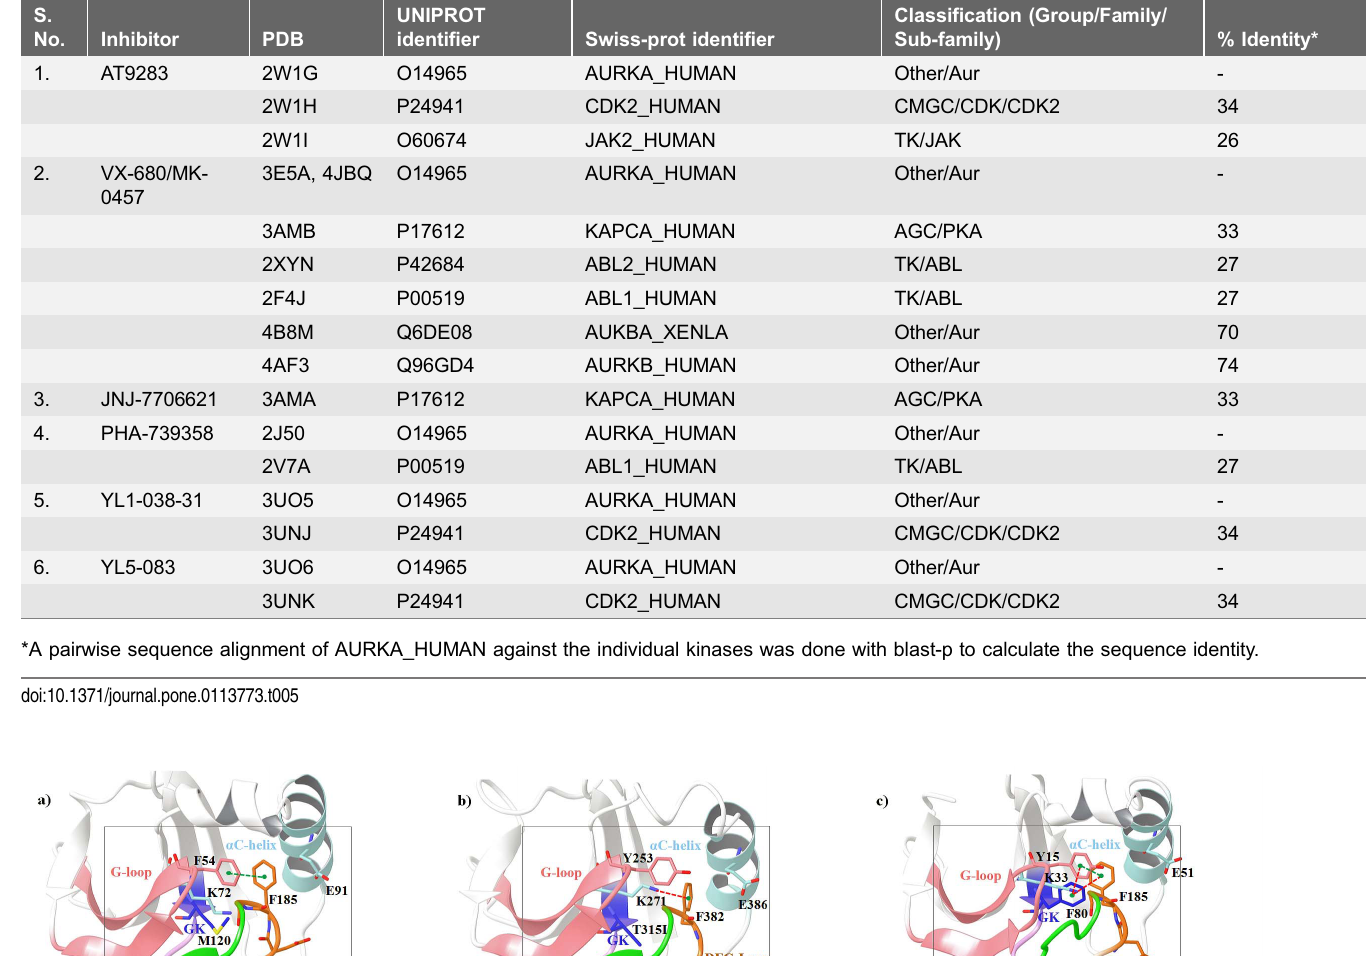
Table 5. Sequence identity of kinases bound by multi-targeted AK inhibitors with AK. S. No.